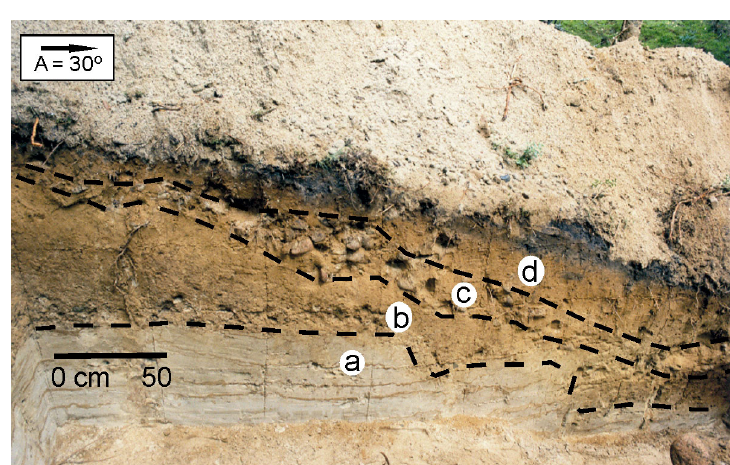
Fig. 4. Geological structure of the slope and a fragment of the bottom of the J2 valley: a, fluvioglacial sediments of the substrate; b, sand and gravel deposits; c, boulder level; d, sands with an admixture of gravels.